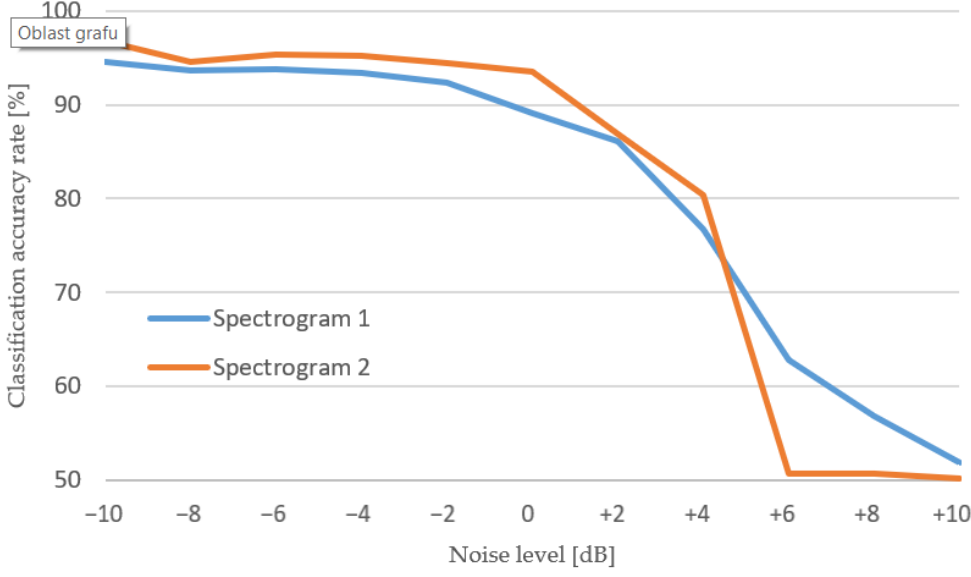
Figure 12. Comparison of both spectrogram types with regard to classification